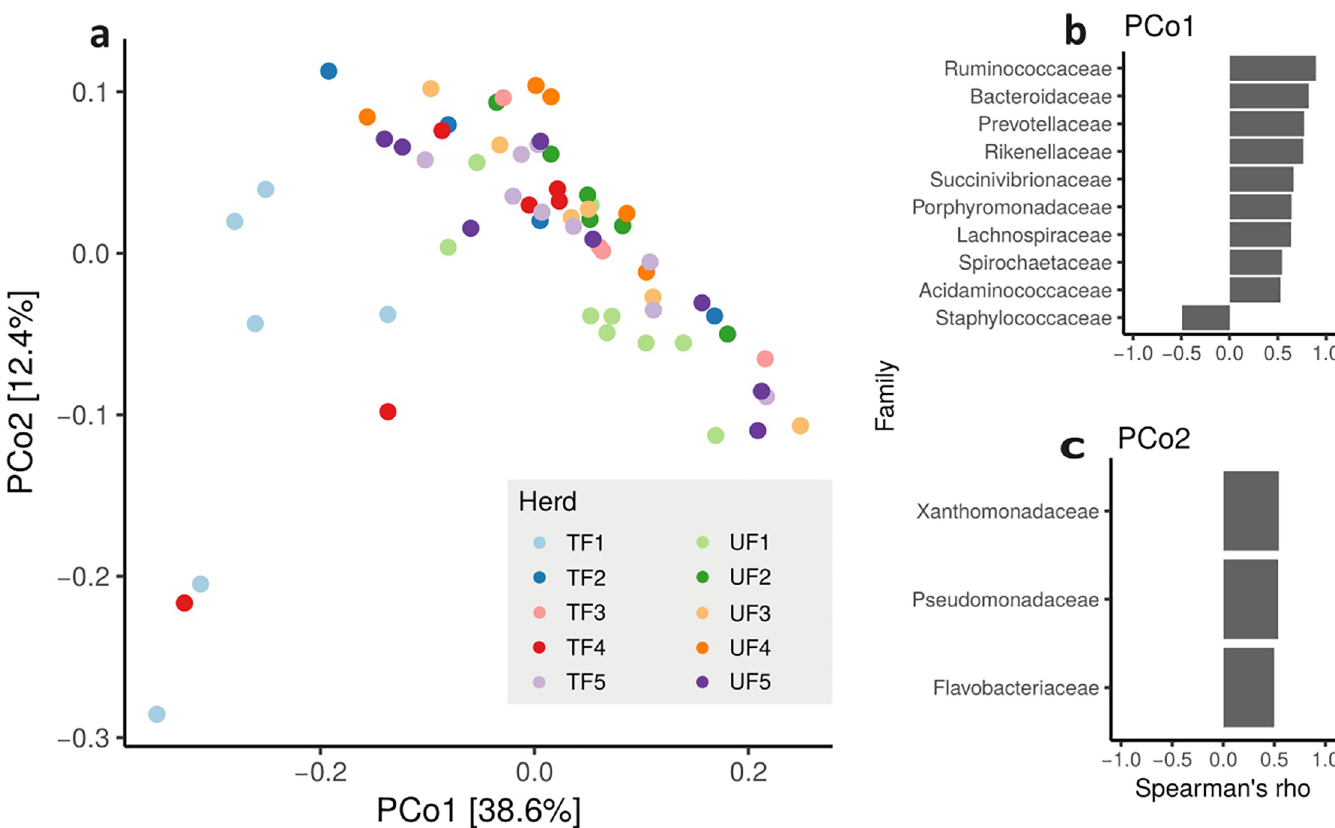
Fig 5. Estimates of raw milk microbiota composition of commercial Alpine dairy cows. (a) Principal Coordinate Analysis (PCoA) of the between samples distances measured using Bray-Curtis dissimilarity; Families that drive variability in raw milk microbiota composition in the first (b) and second (c) principal component. Colored dots identify cows from ten different herds either fed traditionally (TF) or with unifeed (UF) from the Province of Trento, Italy.